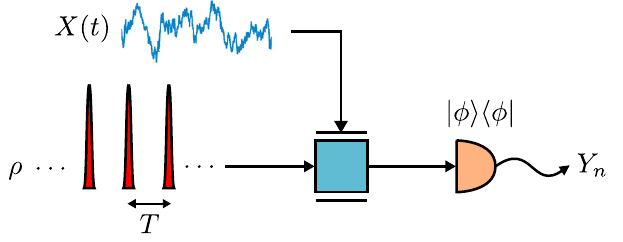
FIG. 6. A pulsed phase measurement scheme to achieve the optimal